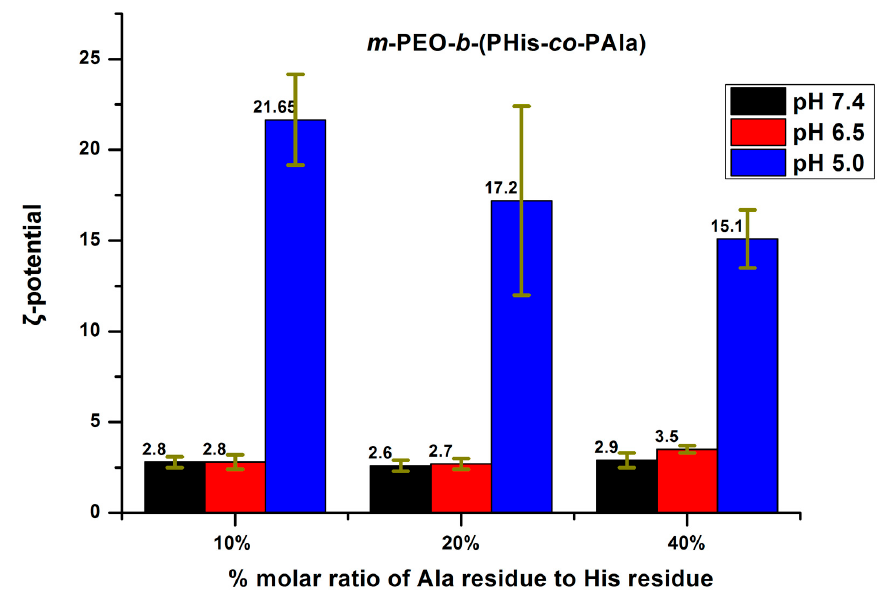
Figure 9. Zeta potential measurements of the synthesized polypeptides containing alanine residues as a function of pH and of alanine to histidine molar ratio